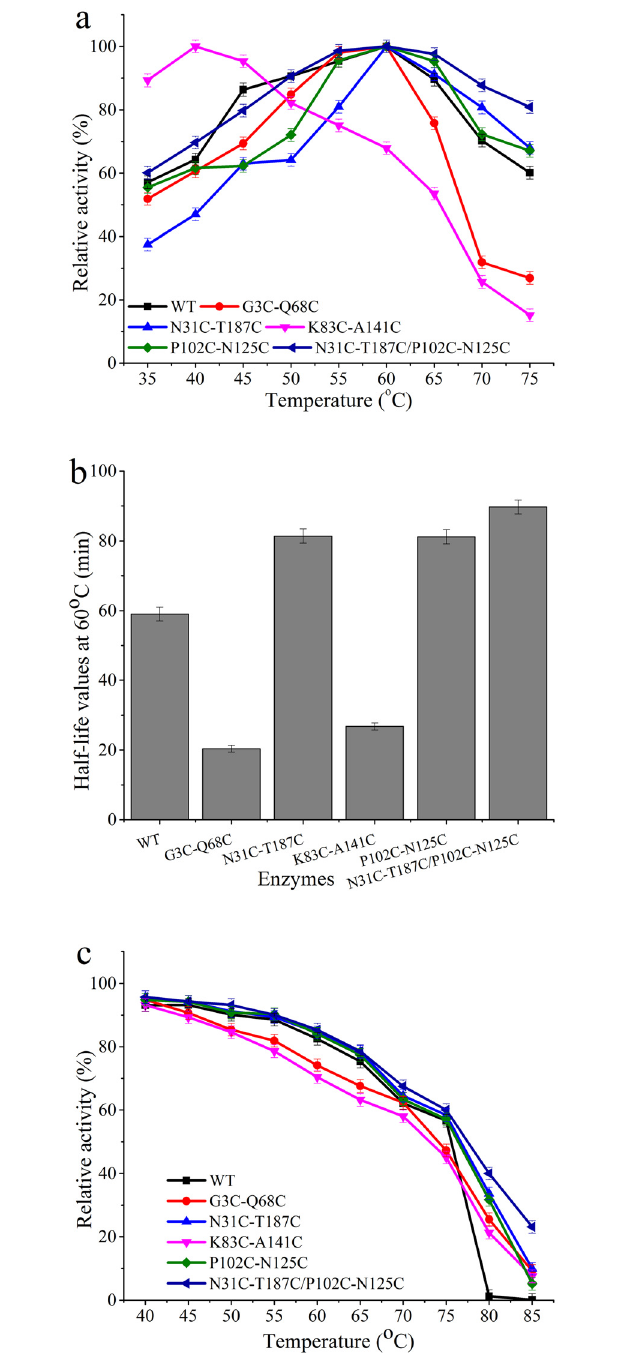
Fig 1. The optimal temperatures (a), enzyme inactivation curves at 60°C (b) and kinetic stability curves (c) of wild-type BglTM and the mutants.